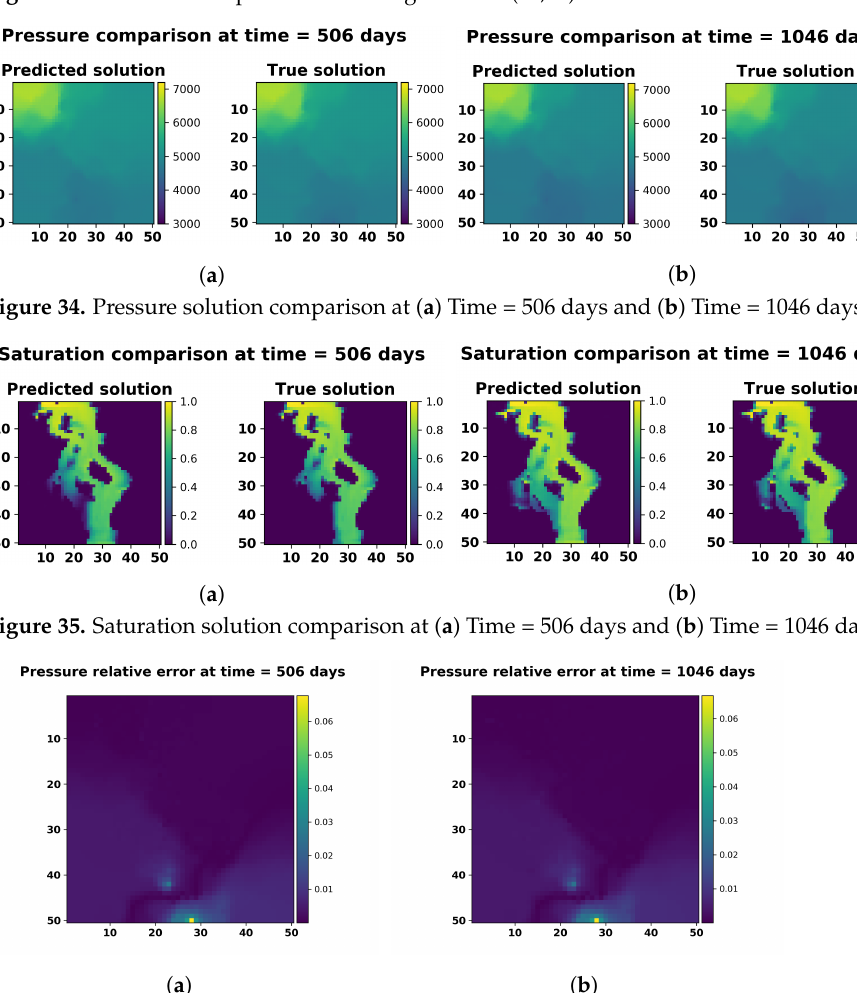
Figure 33. Test case with producer well at grid block (28,50).